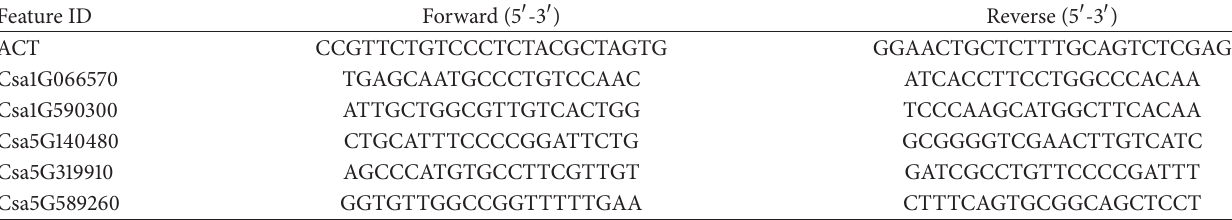
Table 2: qRT-PCR primer sequence (forward and reverse) by gene (feature